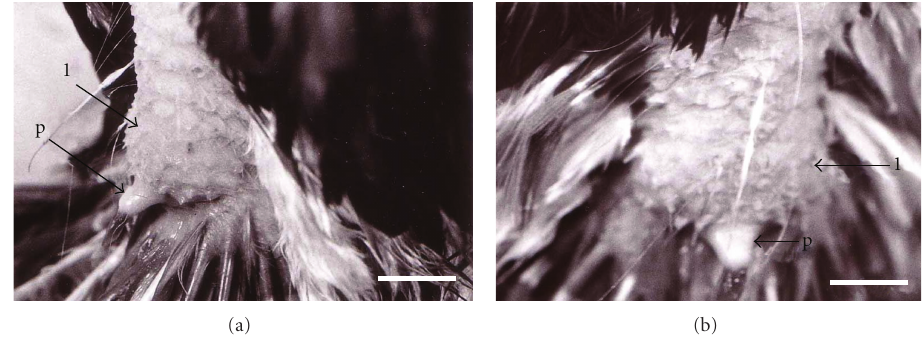
Figure 2: Photographs of the domestic chicken uropygial gland. (a) Lateral and (b) dorsal view of an adult uropygial gland. l: lobe, p: papilla. Scale bars indicate 1